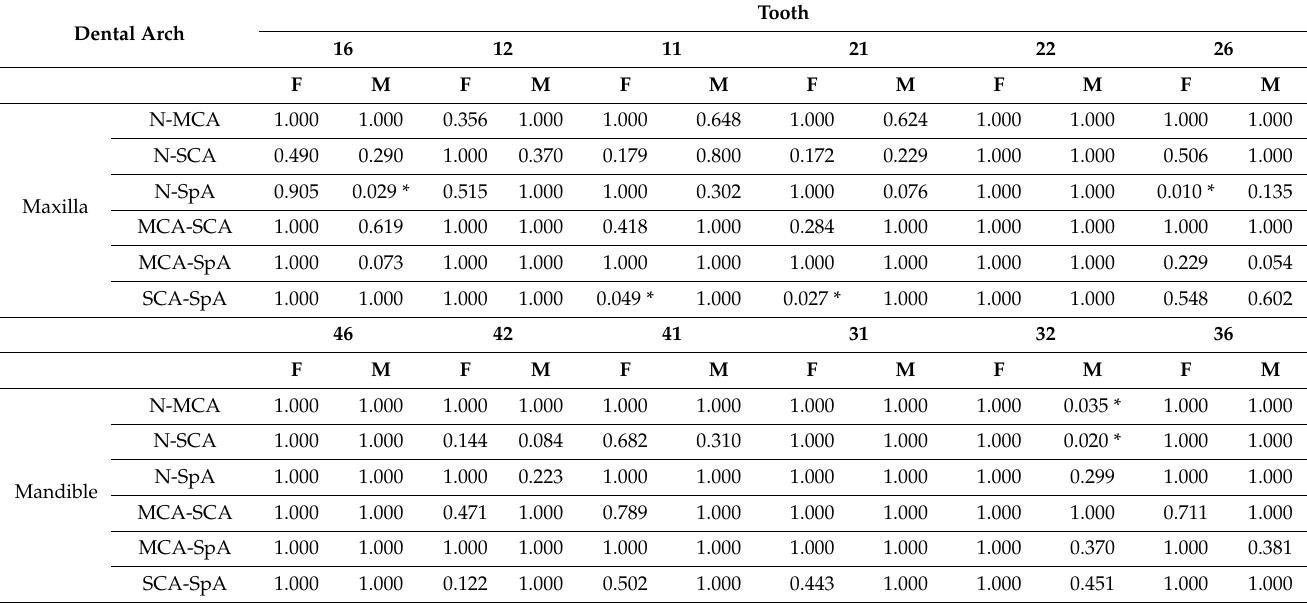
Table 6. Results of the post hoc Bonferroni test ( p values of subgroup comparisons) aimed at comparing the MD dimensions of teeth between the four groups for female and male